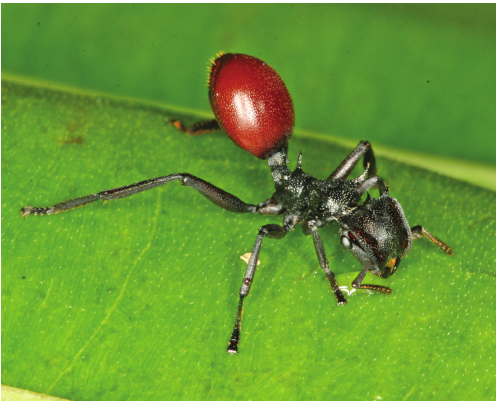
Figure 12: Worker of Cephalotes atratus infected with Myrmecone- ma neotropicum . The raised, red abdomen occurs when the nema- tode eggs are infective and ready for transport by birds. Photo cour- tesy of Stephen P.